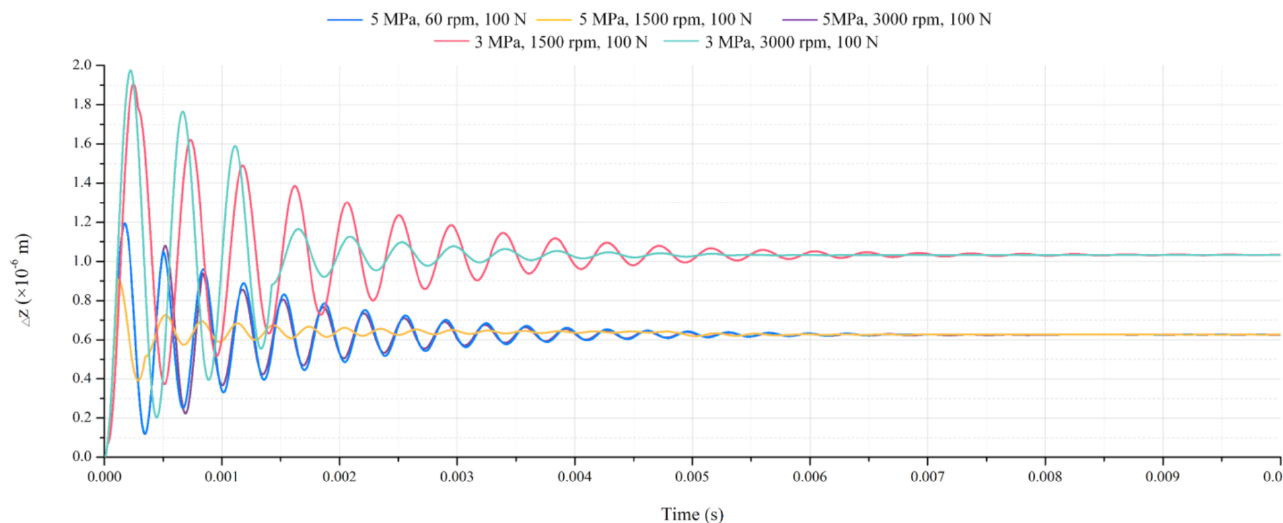
Figure 7. Variation of ∆ z under different angular velocities and oil supply pressures. The simulation results under the conditions of “5 MPa, 60 rpm, 100 N”, “5 MPa, 1500 rpm, 100 N”, “5 MPa, 3000 rpm, 100 N”, “3 MPa, 1500 rpm, 100 N” and “3 MPa, 3000 rpm, 100 N” are represented by the curves in blue, yellow, purple, red and green, respectively. The meanings of the descriptions of the conditions have been explained in Figure 6. In almost every situation, it can be seen that ∆ z is becoming steady when